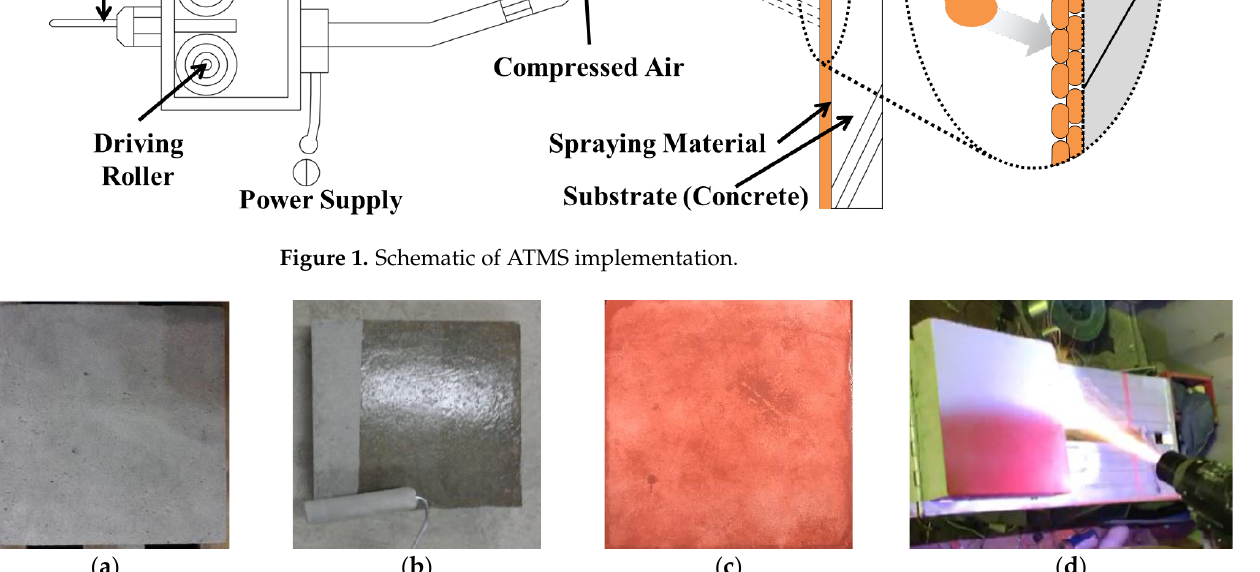
Figure 1. Schematic of ATMS implementation.